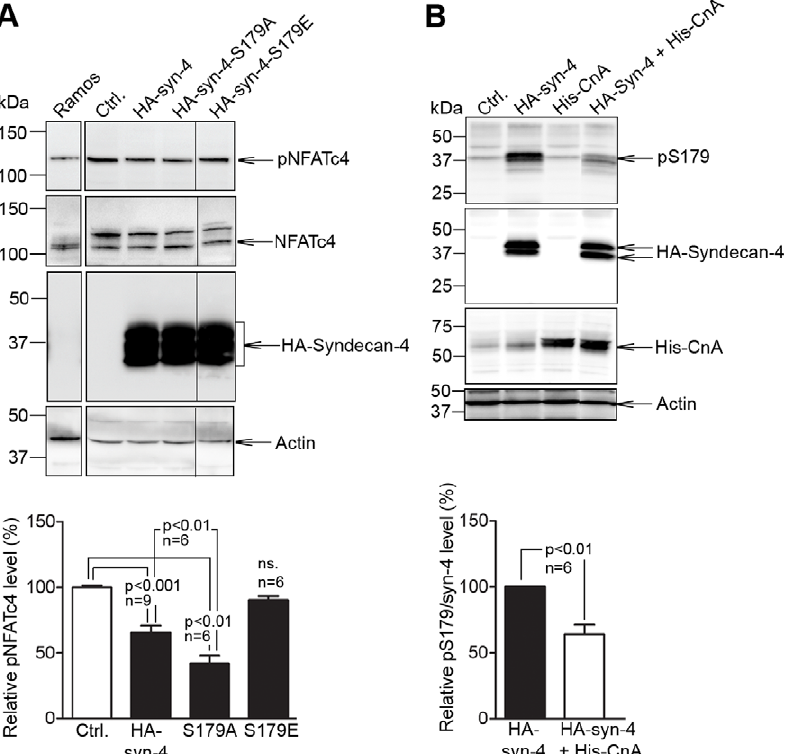
Figure 5. Level of phosphorylated syndecan-4 regulates NFAT activation and is decreased by calcineurin. (A) Phosphorylated NFATc4 (pNFATc4), NFATc4 and syndecan-4 levels in HEK-293 cells transfected with HA-syn-4, HA-syn-4-S179A (mimicking no S179 phosphorylation) or HA- syn-4-S179E (mimicking constitutive S179 phosphorylation) (n=6–9) and (B) pS179-syndecan-4, syndecan-4 and calcineurin A (CnA) levels in HEK-293 cells co-transfected with CnA and HA-syn-4 or HA-syn-4 alone (n=6) analyzed by immunoblotting. Actin was used a loading control. Values are mean 6 s.e.m.